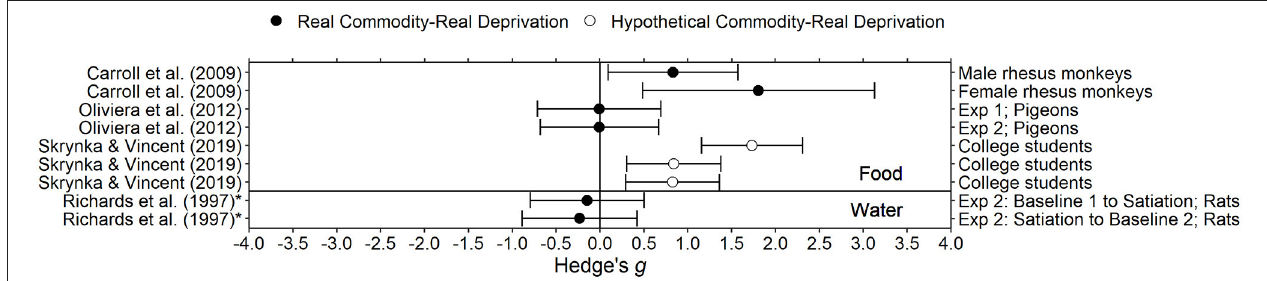
FIGURE 2 | Effect sizes for food and water deprivation experiments. Effect size is Hedge’s g . Points closer to 0 indicate smaller effect sizes. Points to the right of the line indicate increases in delay discounting due to deprivation, the predicted effect. Solid circles indicate that the delay discounting task used real outcomes and subjects experienced real deprivation. Unfilled circles indicate that the delay discounting task used hypothetical outcomes and subjects experienced real deprivation. *Indicates the effect size was calculated using non-transformed k -values and thus may be